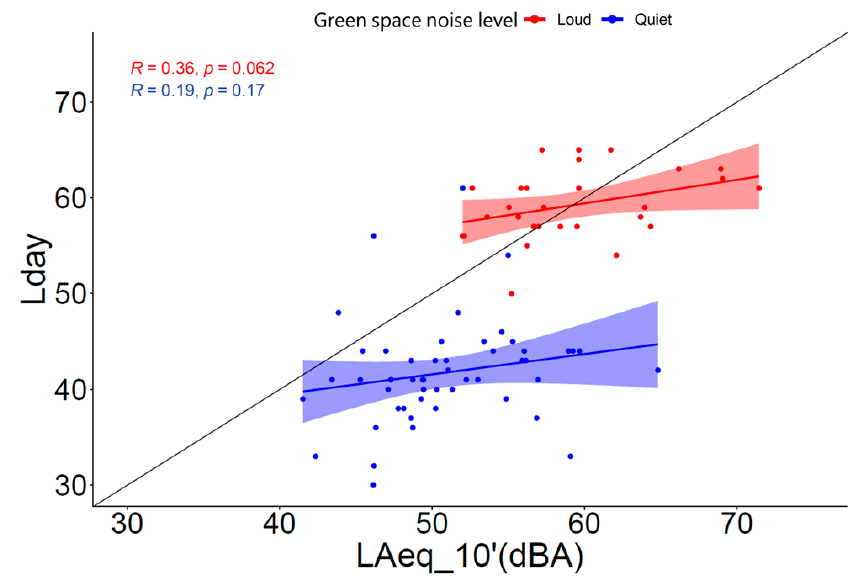
Figure 7. Correlation between L day obtained from the sonBASE database and L Aeq_10 ′ obtained from measurements with Pearsons’ correlation coefficients ( R ) and p -values.